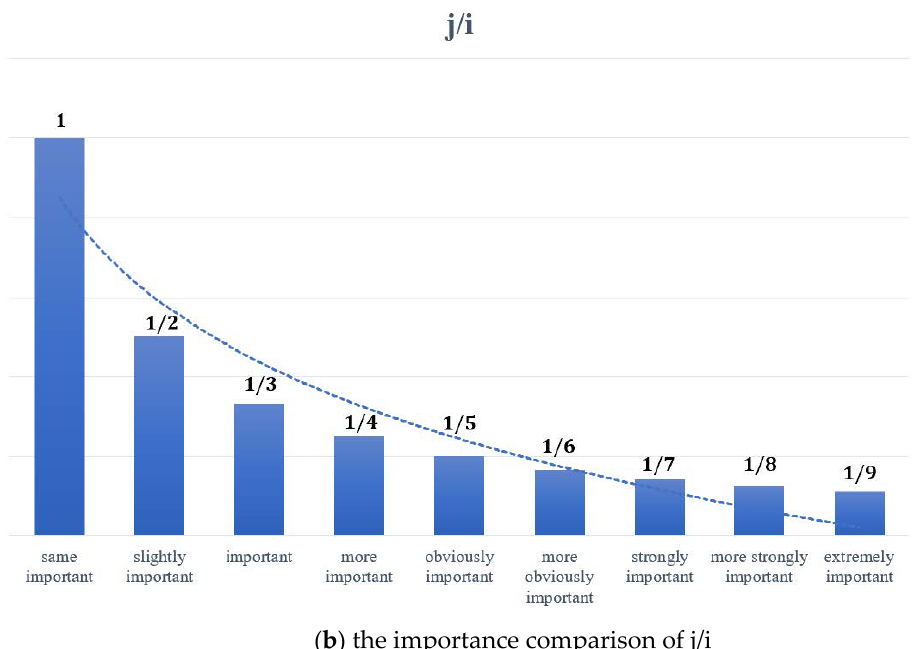
Figure 7. the construction principles of judgment matrix. Figure 7. The construction principles of judgment matrix.